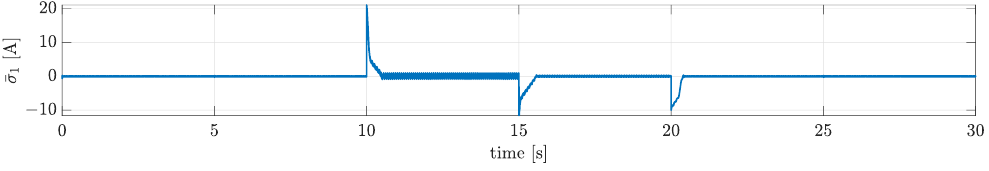
Figure 11. Buck mode. Sliding variable ¯ σ 1 in